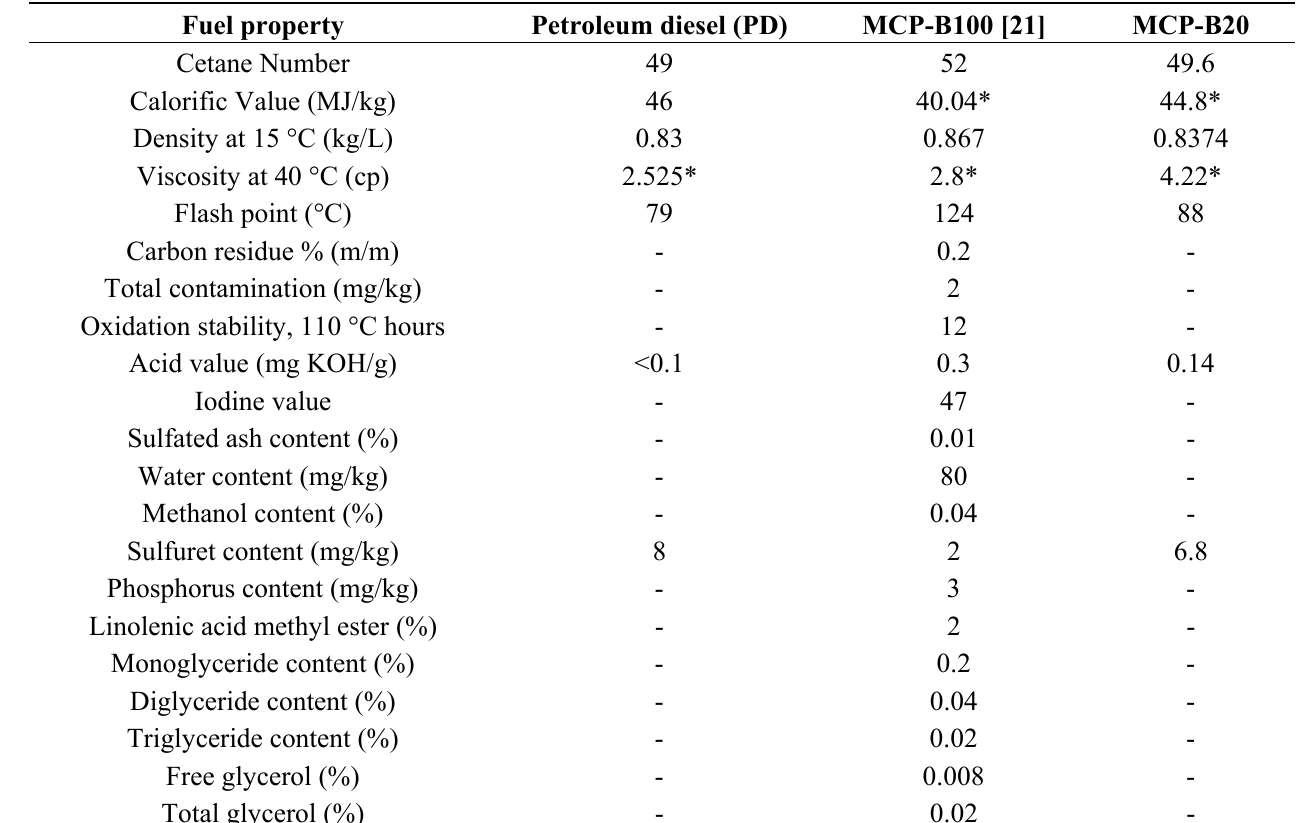
Table 2. Fuel properties [20].